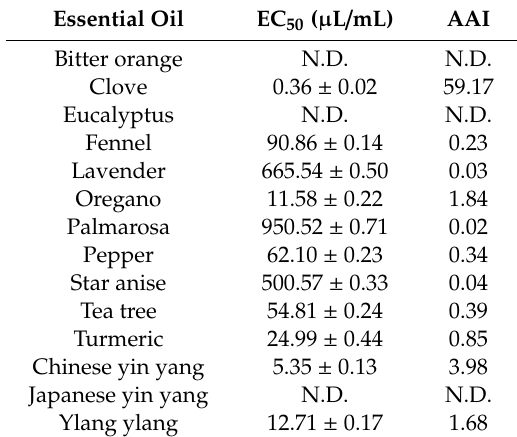
Table 4. Antioxidant activity of EOs measured by 2,2-diphenyl-1-picrylhydrazyl (DPPH) method and expressed as EC 50